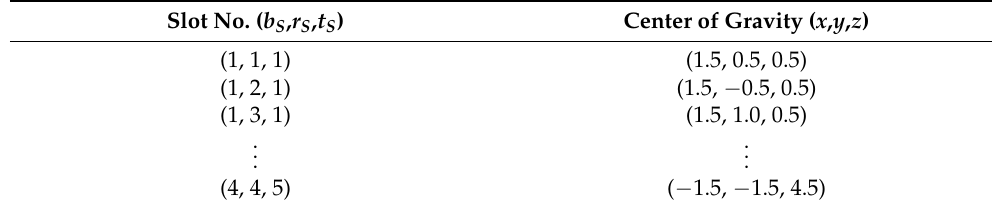
Table 4. Container ship slot location